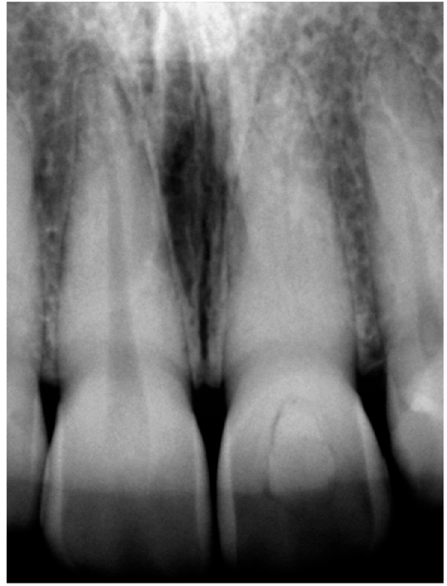
Figure 2. Periapical radiography showing obliteration of the pulp chamber and root canal of the upper left central incisor. Pulp sensitivity test showed positive reaction.